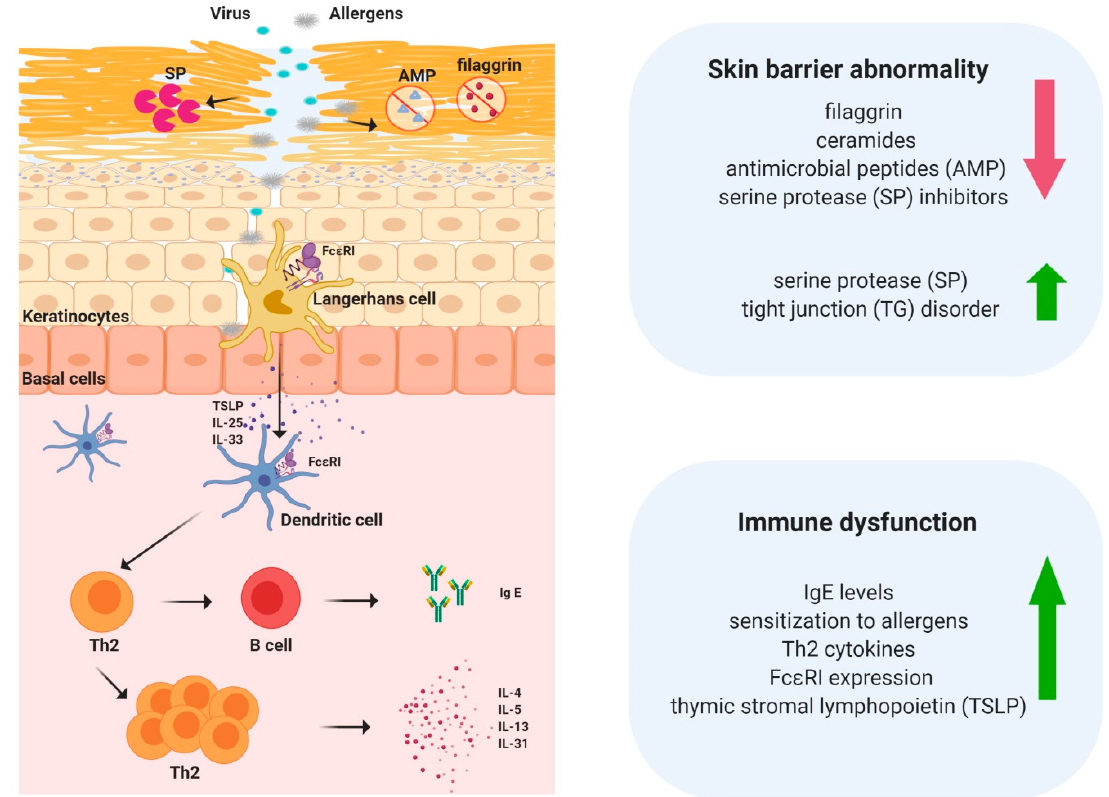
Figure 1. Skin barrier abnormalities and immune dysfunction are the main features of atopic dermatitis.